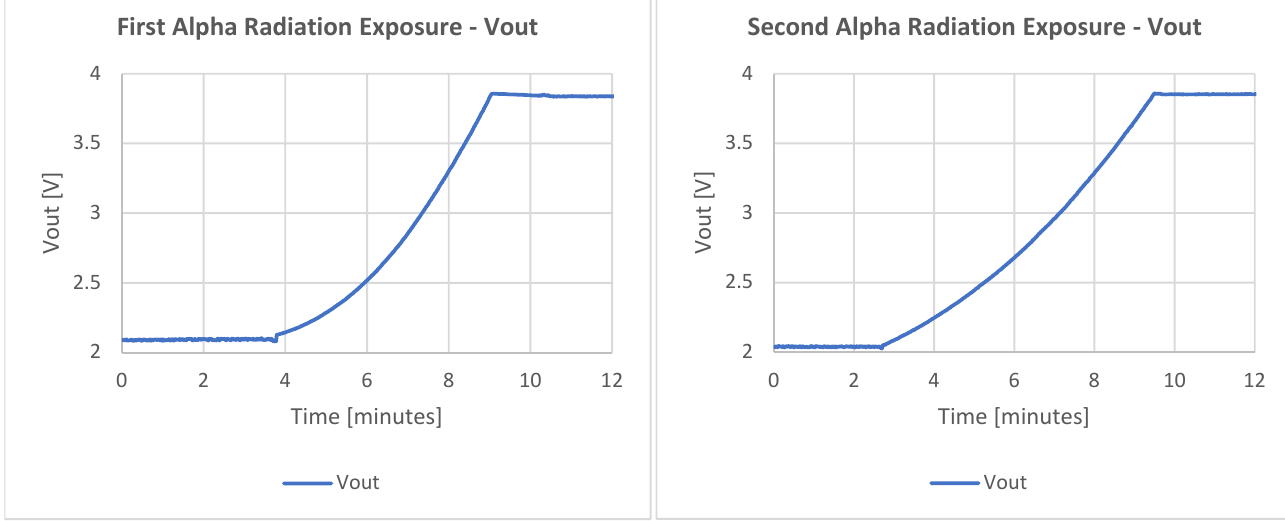
Figure 9. 𝑽 𝒐𝒖𝒕 profile during alpha radiation exposure. 𝑽 𝒐𝒖𝒕 is measured at the output of the TIA (see Figure 6a). Figure 9. V out profile during alpha radiation exposure. V out is measured at the output of the TIA (see Figure 6a). Table 1. Summary of CMOS Sensor exposure to Alpha radiation.